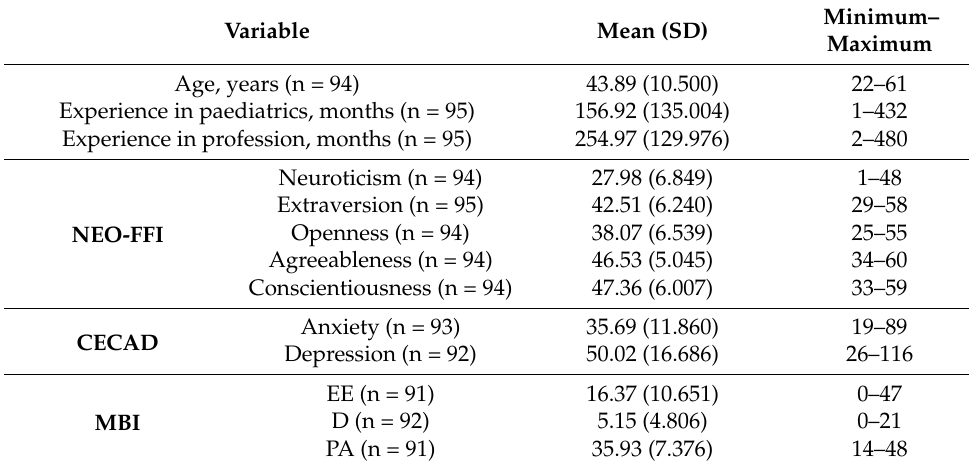
Table 2. Descriptive data and quantitative variables.